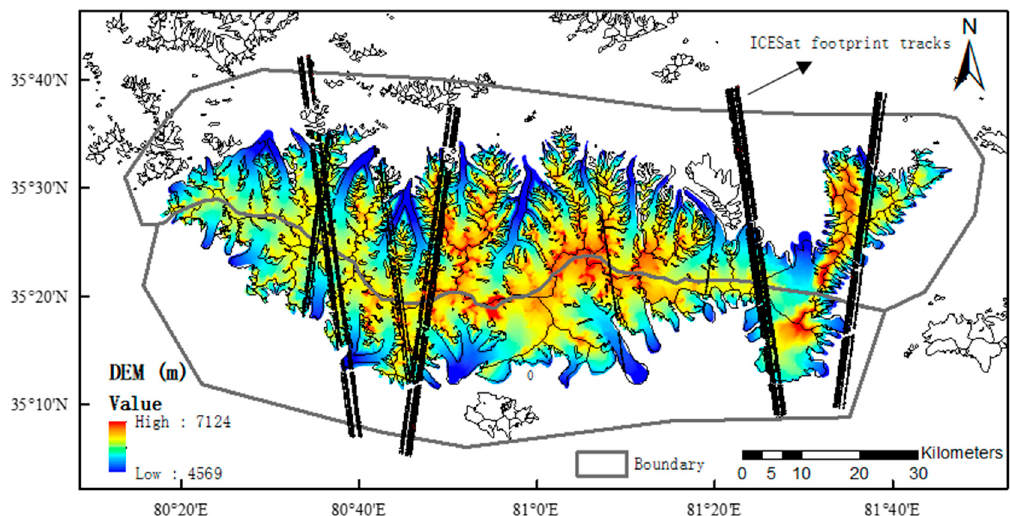
Figure 1. Study area: West Kunlun Mountains glaciers investigated in this study, SRTM-DEM elevations of the West Kunlun Mountains glacier obtained in 2000, and ICESat footprint coverage over glacier-covered and off-glacier areas within 15 km.